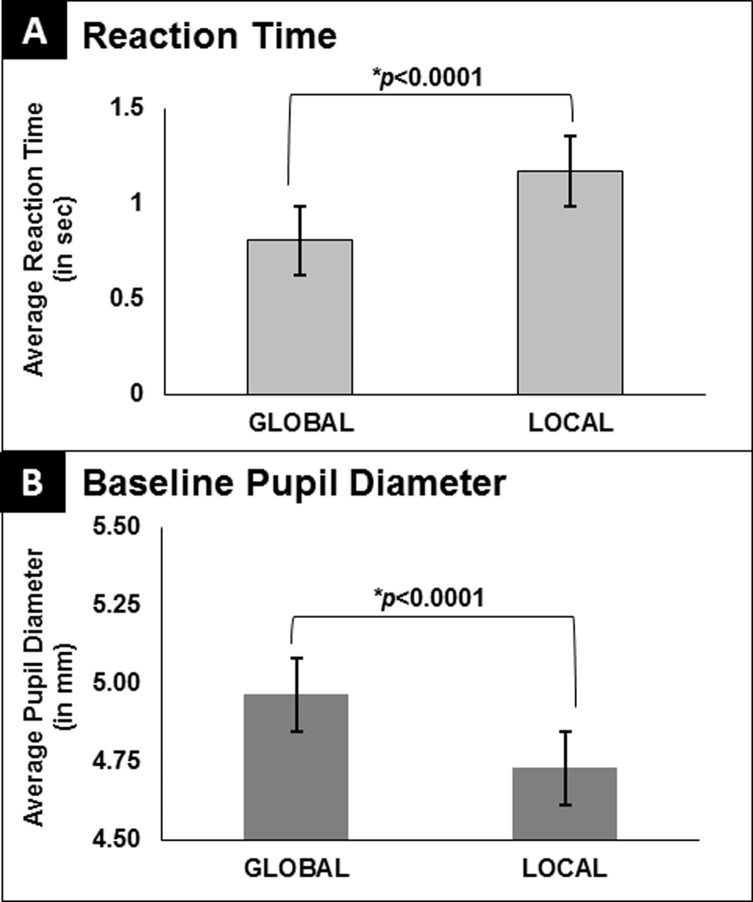
Behavioral results and baseline pupil diameter.(A) Group differences in average reaction time (in sec) for the global and local conditions. (B) Group differences in average baseline pupil size (in mm) for the global and local conditions. Error bars indicate standard error of the mean.